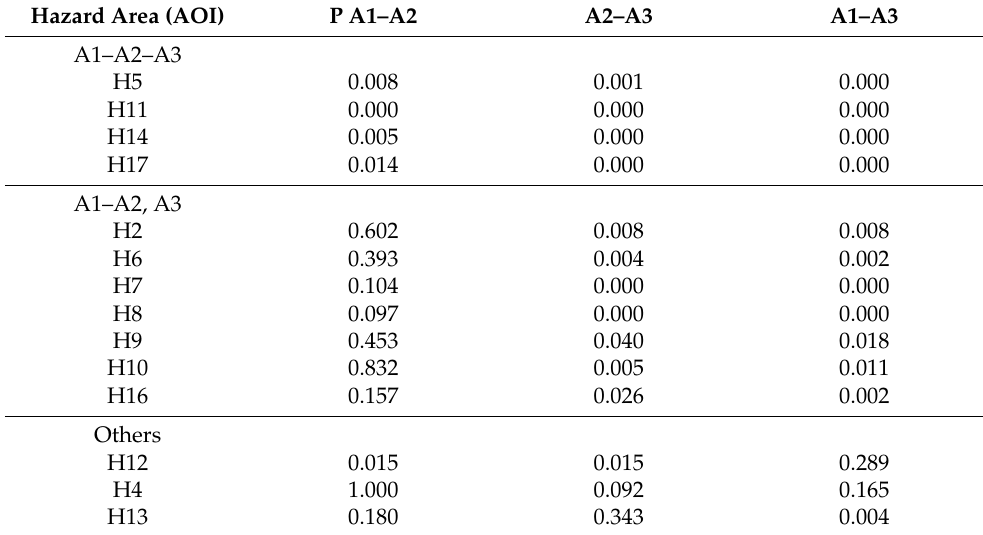
Table 8. The test-LSD for mean fixation